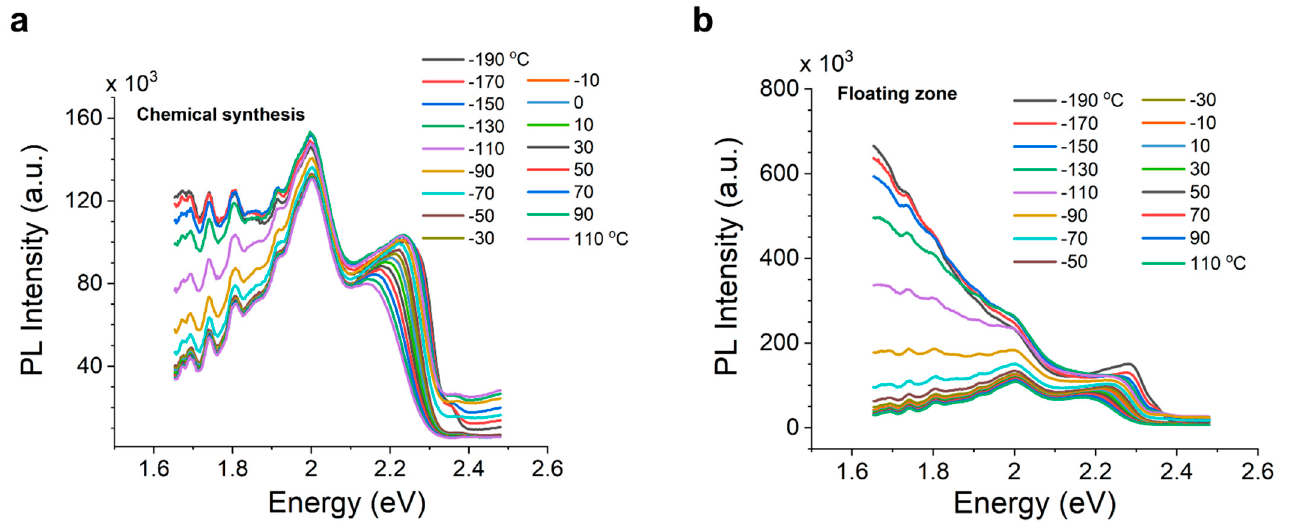
Figure 6. Temperature-dependent solid state PL spectra of CsPbBr 3 obtained from ( a ) chemical syn- thesis, λ ex = 293 nm and ( b ) floating zone method; λ ex = 291 nm. Figure 7a,b show the FLIM image and phasor plot of the CsPbBr 3 sample prepared using the floating zone method. The corresponding FLIM image and phasor plot of the